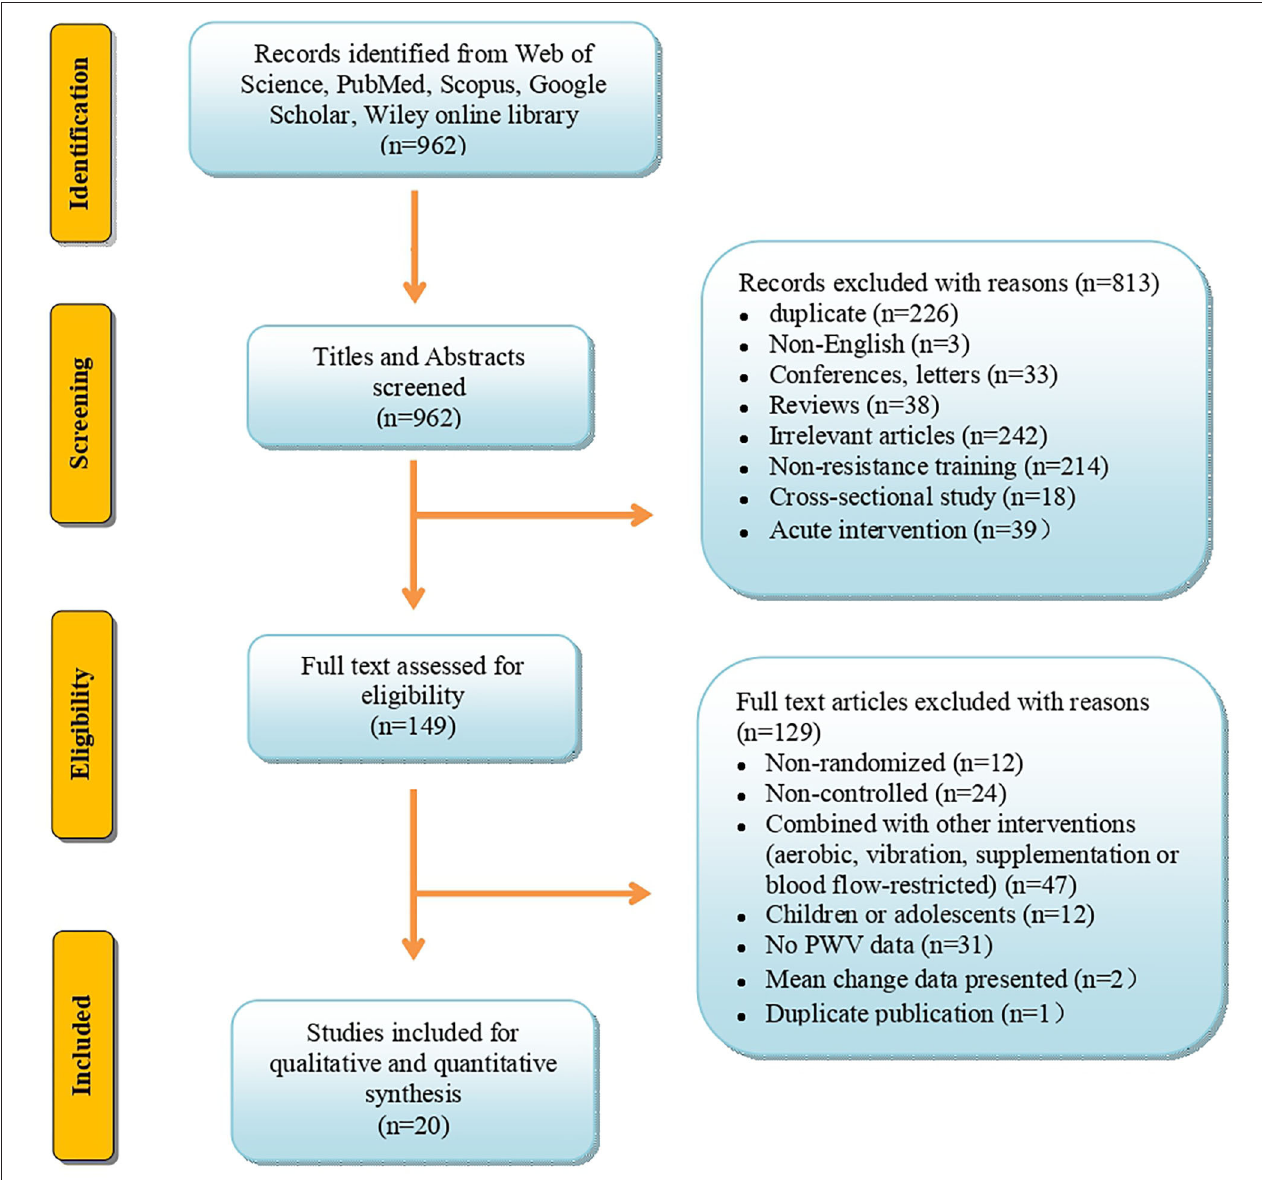
FIGURE 1 | Flow diagram depicts the article search, exclusion, and inclusion according to the Preferred Reporting Items for Systematic Reviews and Meta-Analyses (PRISMA).